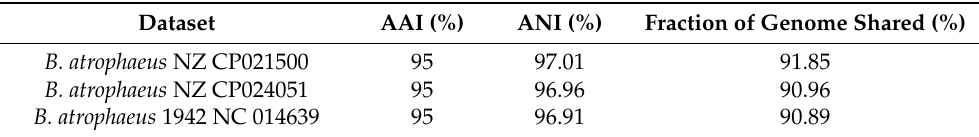
Figure 1. Characterization of the bacterial isolate: SEM images showing the BU4 isolate ( a ) at 15,000 × and ( b ) 30,000 × magnification. Arrows indicate ( a ) EPS covering and connecting bacteria, and ( b ) EPS strands connecting clusters of bacteria. Phylogenetic tree ( c ) based on single-copy genes identified by next-generation sequencing. Support values calculated by RAxML using 100 rounds of “Rapid bootstrapping” are provided. Table 1. Average sequence identities to the reference datasets 1